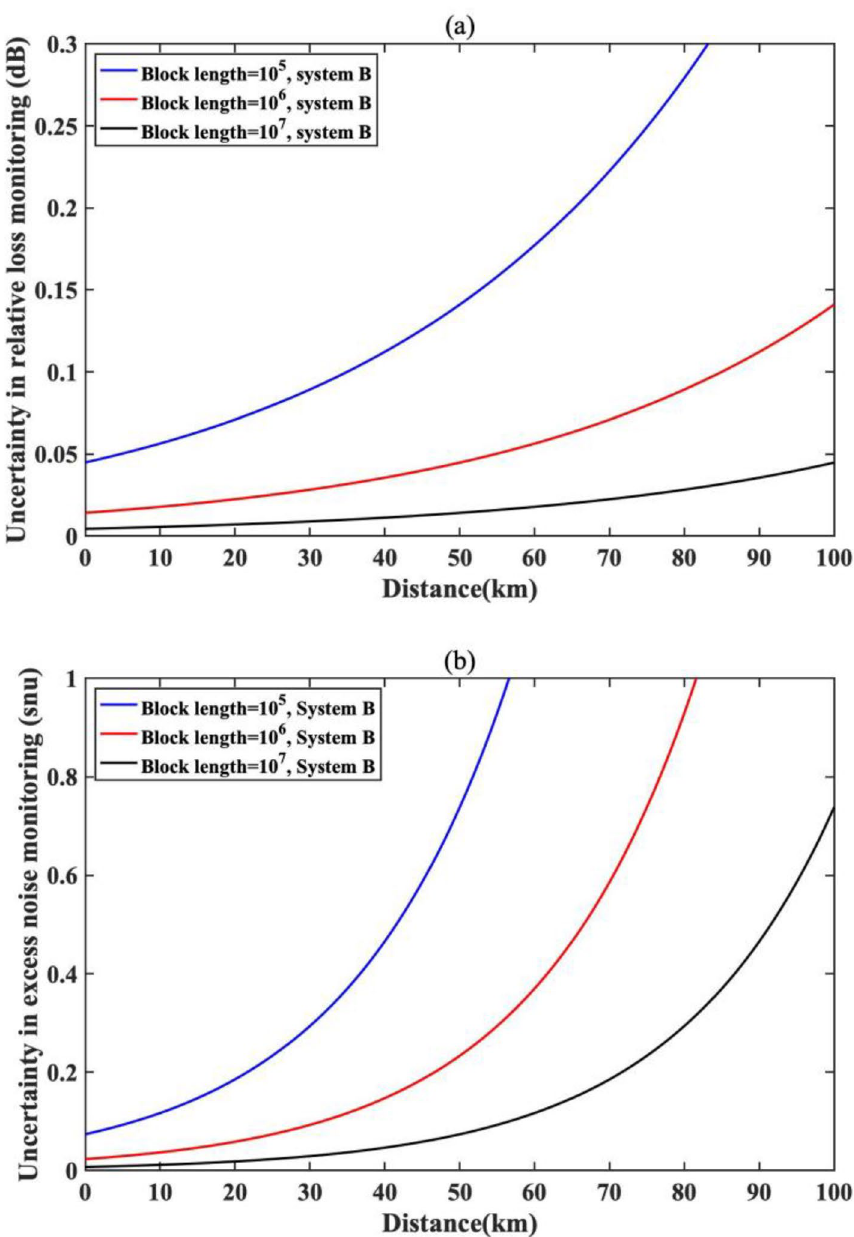
Figure 2. Accuracy of the quantum monitoring system. ( a ) Estimation uncertainty in loss monitoring. ( b ) Estimation uncertainty in excess noise